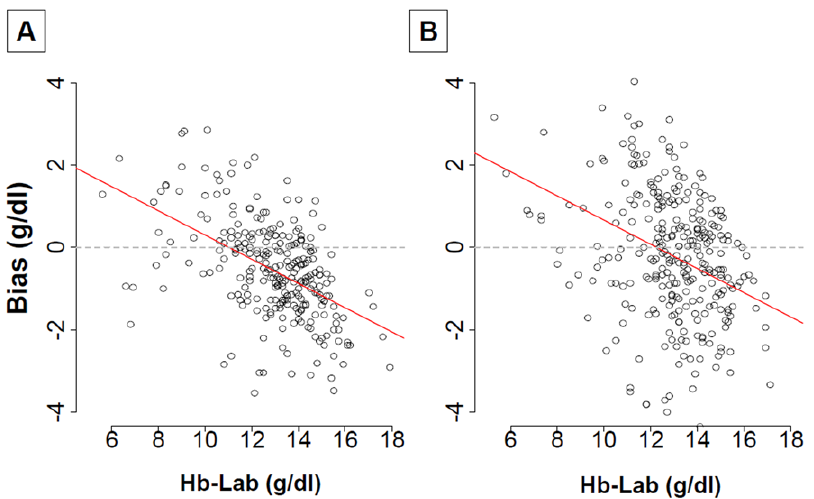
Figure 4. Association between true values of hemoglobin and bias. Results for the Pronto-Study are displayed on the panel A and for the Orsense-Study on the panel B. The red line represents the linear regression relationship between the true value of hemoglobin and the bias. There is an inverse correlation between hemoglobin and bias in both studies (Spearman correlation coefficients at - 0.51, p , 0.0001 and -0.37, p , 0.0001 for the Pronto-Study and the Orsense-study, respectively).